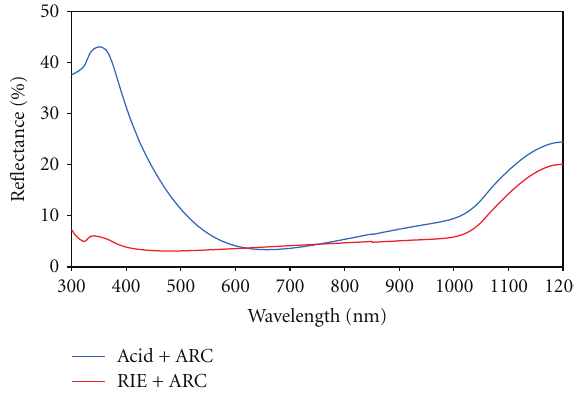
Figure 2: SEM images of textured surfaces: (a) acid textured surface 5000x, (b) RIE-textured surface 5000x, (c) acid textured surface 30000x, and (d) RIE-textured surface 30000x.